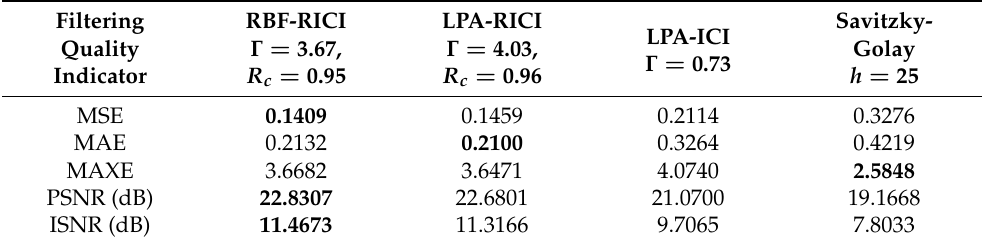
Table 1. Blocks signal (SNR = 5 dB)—Filtering results. The best filtering quality indicators are marked in bold.